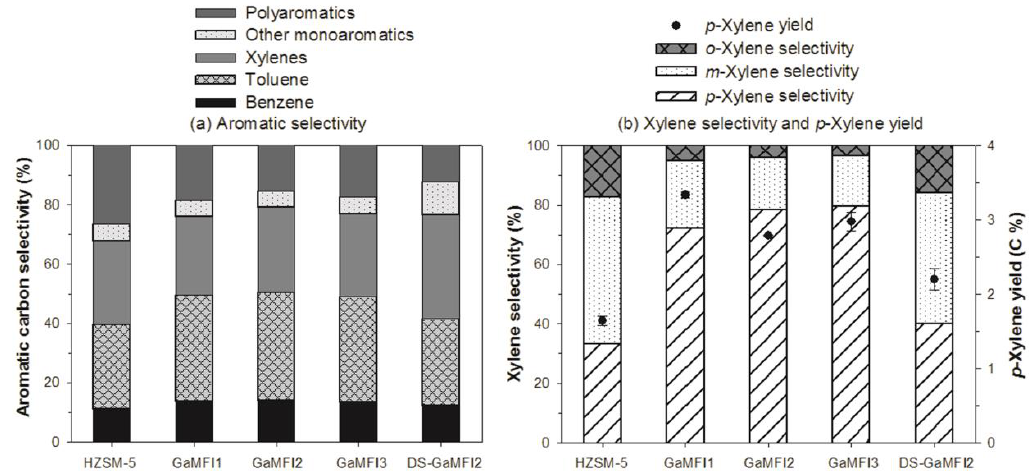
Figure 4. ( a ) Aromatic products selectivity, and ( b ) xylene selectivity and p -xylene yields from CFP of beech wood with HZSM-5 and Ga-containing MFI